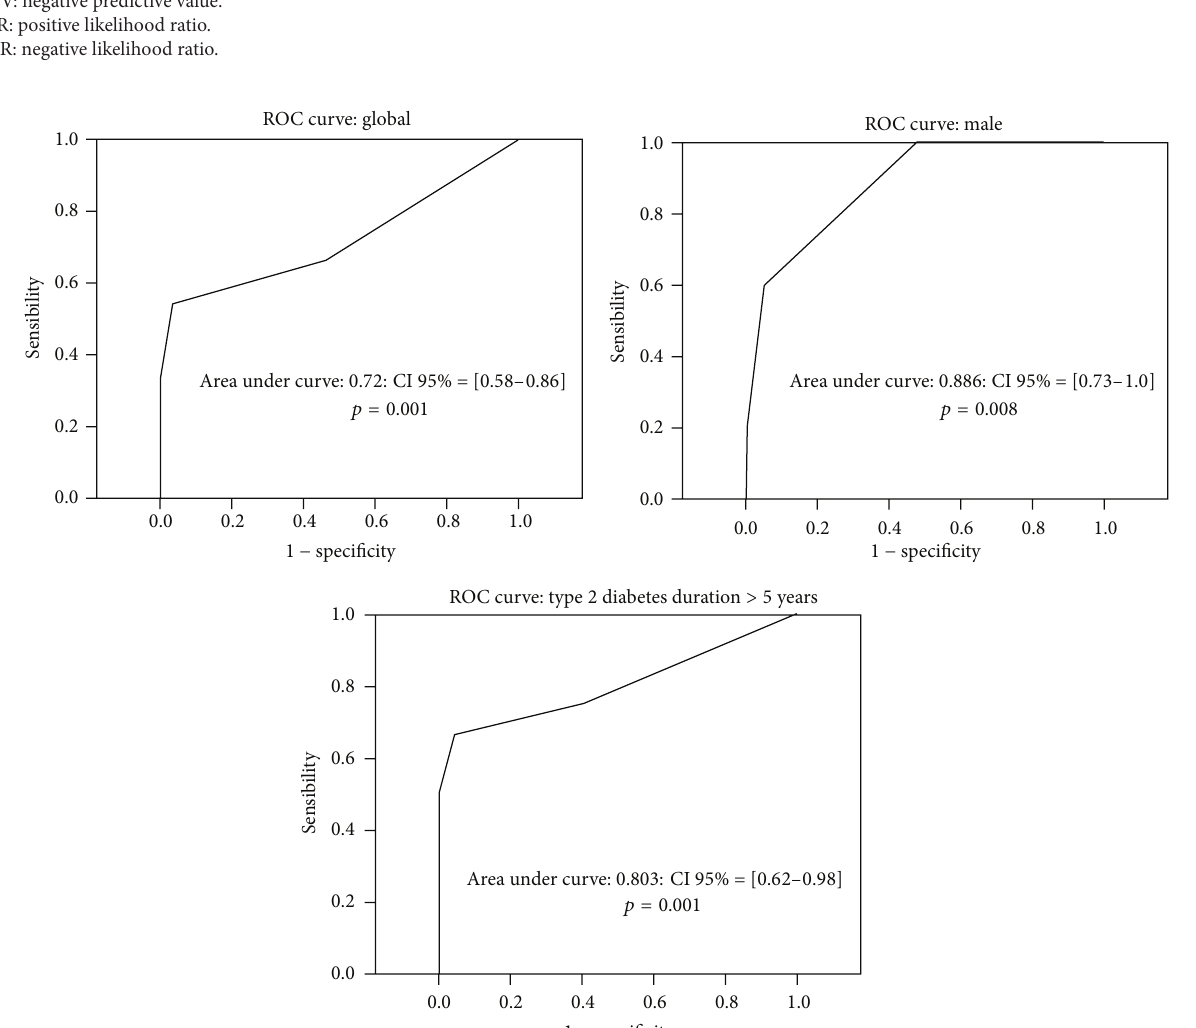
Figure 1: The area under the ROC curve of Micral-test (mg/L) in microalbuminuria